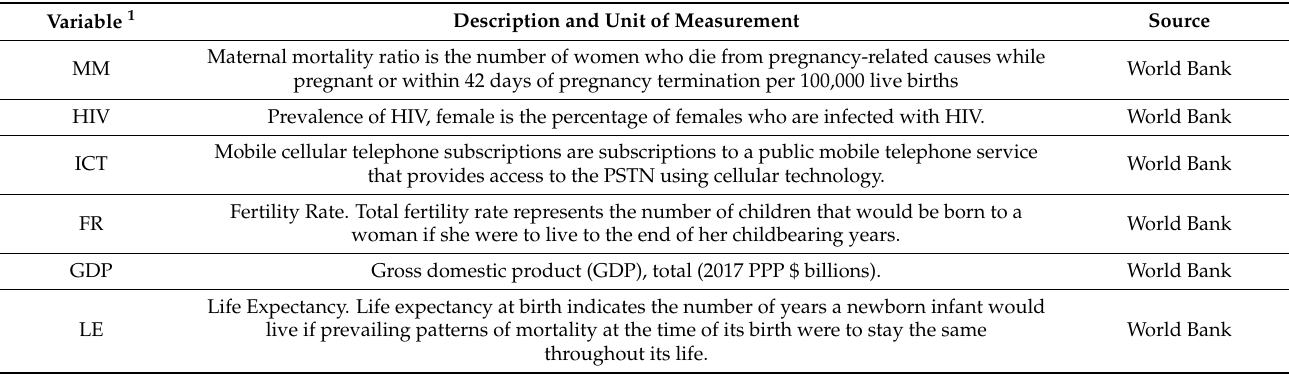
Table 2. Summary of Variable Description. Description and Unit of